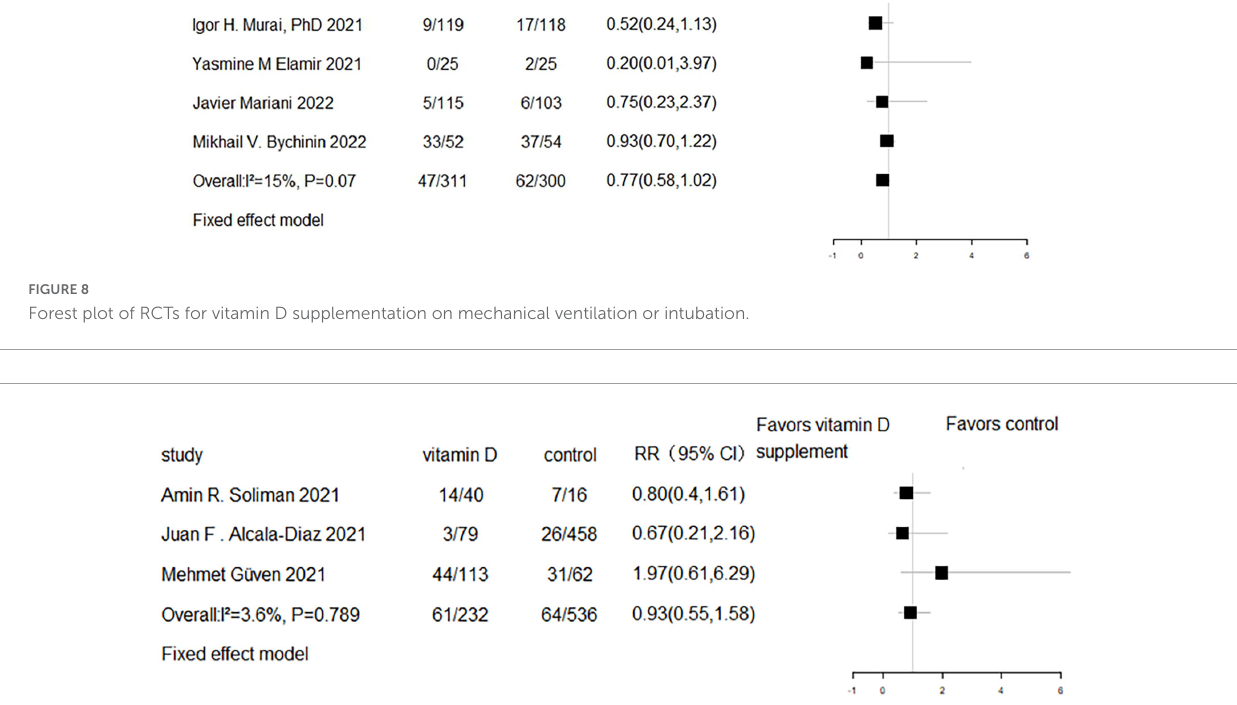
FIGURE9 Forest plot of cohort studies for vitamin D supplementation on mechanical ventilation or